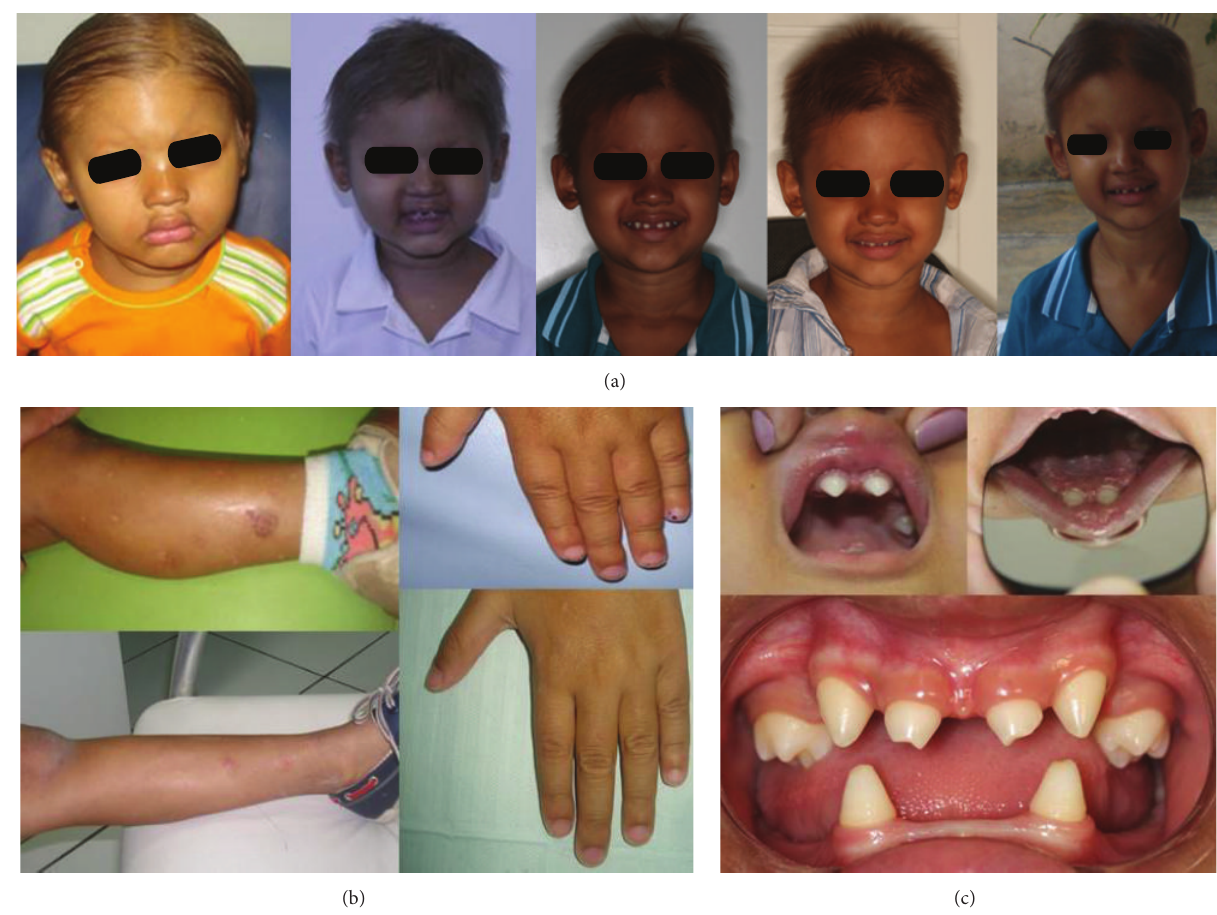
Figure 1: (a) Patient’s visage at 2, 3, 4, 5, and 6 years of age with sparse hair, frontal bossing, saddle nose, and everted prominent lips. (b) Bright, dry skin on the leg; normal nails. (c) Intraoral examination showing variation in the timing and shape of the teeth, hypodontia, and ogival